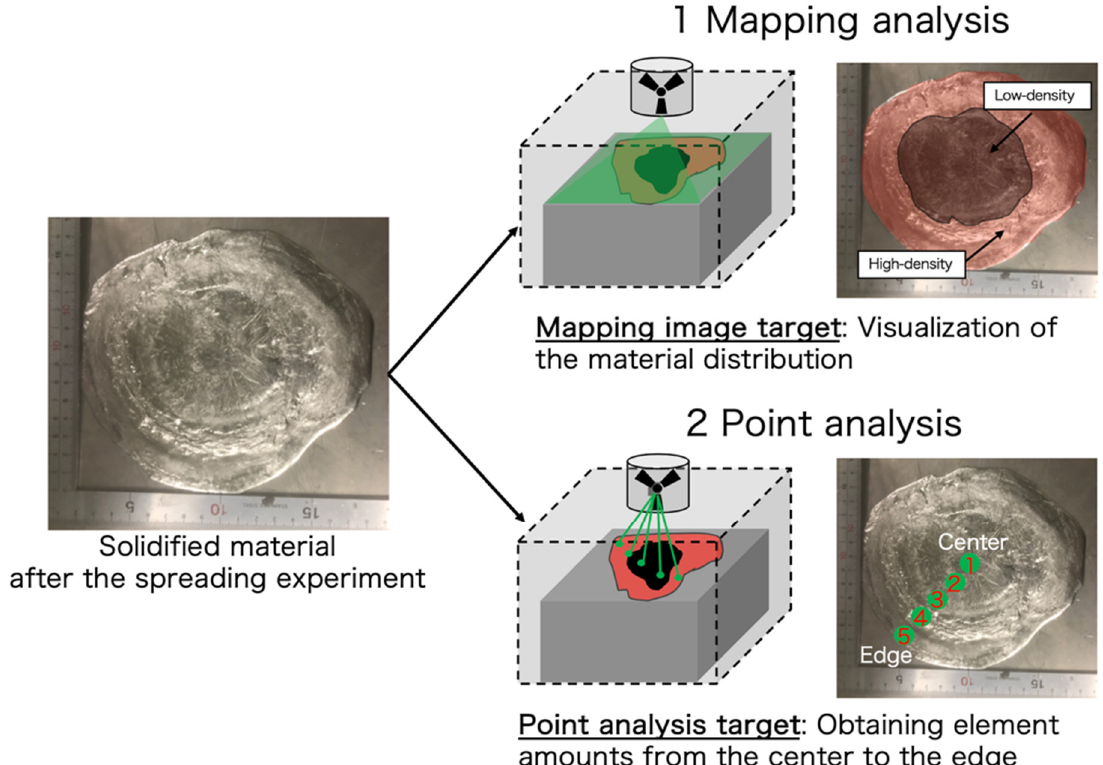
Figure 4. Procedure of the X-ray analysis.